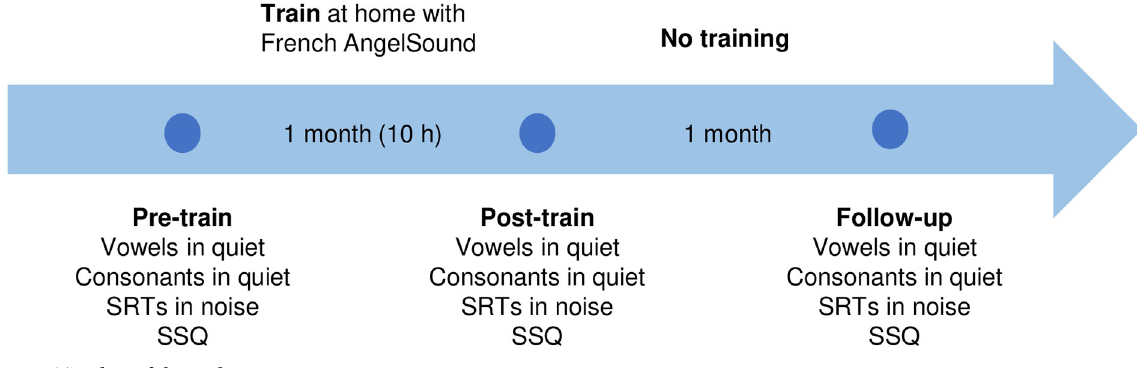
Fig 1. Timeline of the